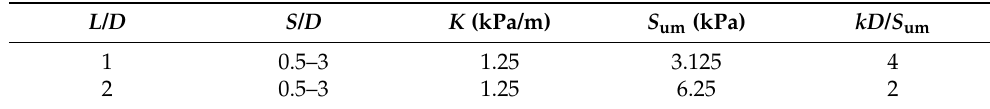
Table 2. Input values for analyzing the effect of non-homogeneity of